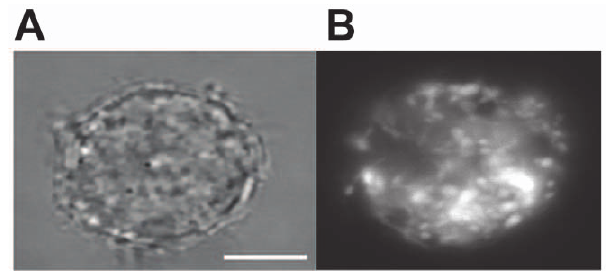
Figure 1. An isolated HL-60 cell. (A) A brightfield image of an HL-60 cell and (B) A confocal scan of the same cell showing mitochondria fluorescently labeled with Mitotracker Green FM. The scale bar corresponds to 5 microns.